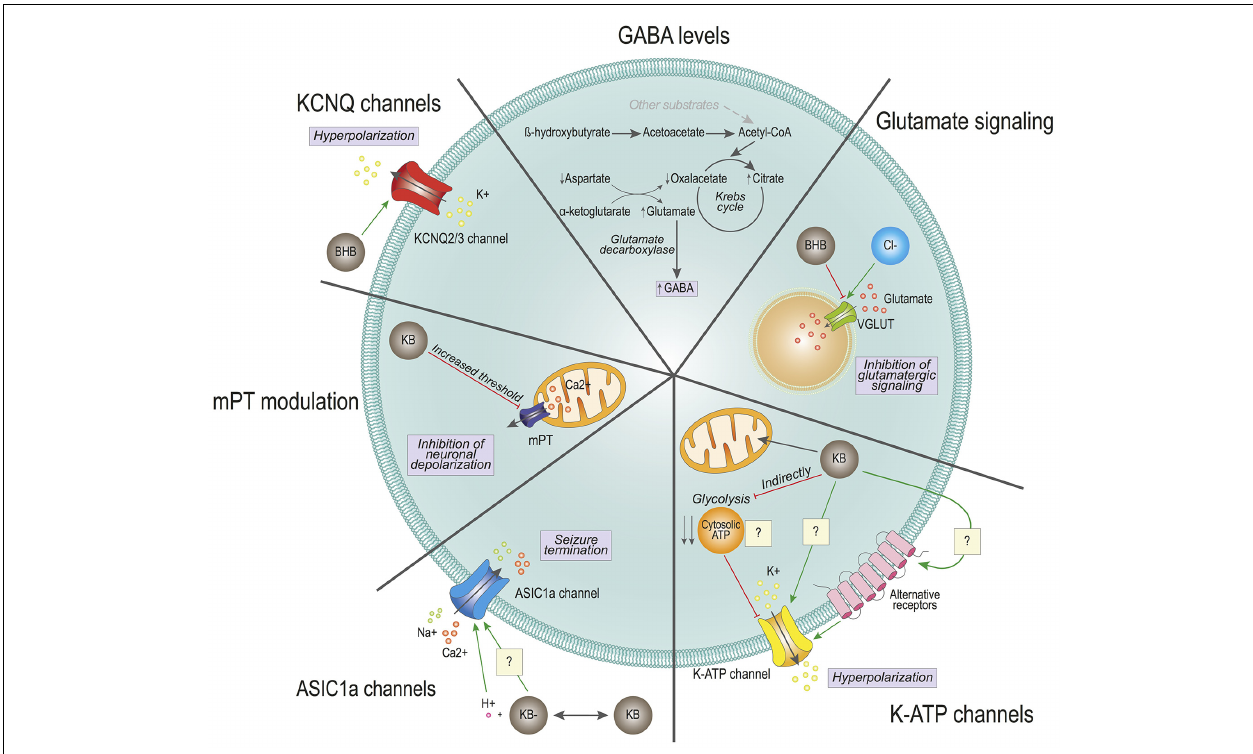
FIGURE 1 | Effects of ketone bodies on cell excitability. The proposed mechanisms for ketone bodies’ (KBs) action on neuronal excitability are depicted. GABA levels: KB β -hydroxybutyrate (BHB) and acetoacetate are converted into Acetyl-CoA at a faster rate than with other substrates, which enters the Krebs cycle reducing the levels of oxaloacetate. To replenish the Krebs cycle, aspartate is converted to oxaloacetate, generating high levels of glutamate. Through the glutamate decarboxylase of GABAergic neurons, glutamate is converted into GABA, increasing the intracellular GABA pool. Glutamate signaling: BHB competes with chloride (Cl-) for the allosteric binding site of the vesicular glutamate transporter (VGLUT). The competition reduces the levels of glutamate inside the vesicles and reduces glutamatergic signaling. K-ATP channels: Ketone bodies (KBs) enter directly into the mitochondria, without generating cytosolic ATP. The lack of cytosolic ATP could provoke the activation of potassium ATP-sensitive (K-ATP) channels, causing the hyperpolarization of the cell. K-ATP channels may also be modulated directly by KBs or indirectly through the activation of alternative receptors. ASIC1a channels: KBs generate a local decrease in pH, which activates the acid sensing ion channel (ASIC1a). These channels participate in seizure termination. KBs may also directly modulate the ASIC1a. KCNQ2/3 channels: BHB directly activates KCNQ channels, which generate a potassium current. This potassium current causes the hyperpolarization of the cell. KBs may also regulate neuronal excitability by participating in mitochondrial permeability transition (mPT) and subsequent oscillations in cytosolic calcium levels.